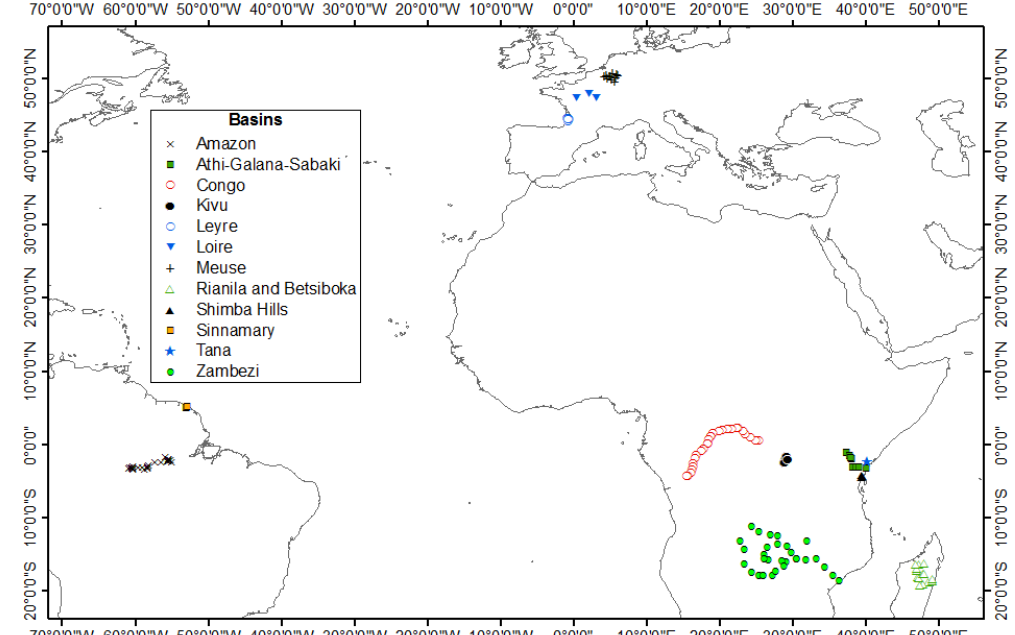
Figure 1. Location of the sampling sites in Africa, Amazonia, and